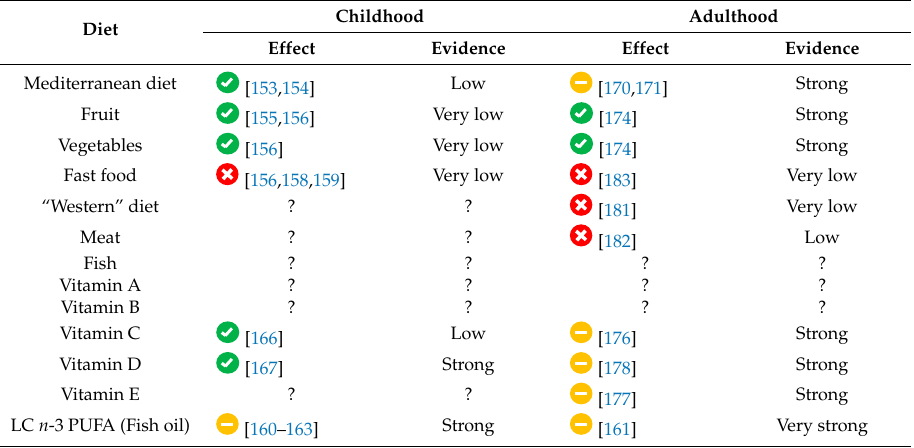
Beneficial effect; negative effect; No Table 1. Diet and risk of asthma or wheezing.